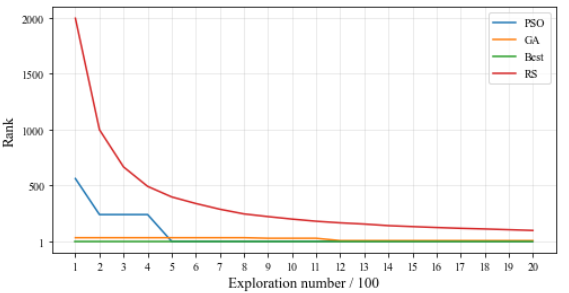
Figure 7. PMU placement ranking based on number of exploration: 33-bus system, N m =